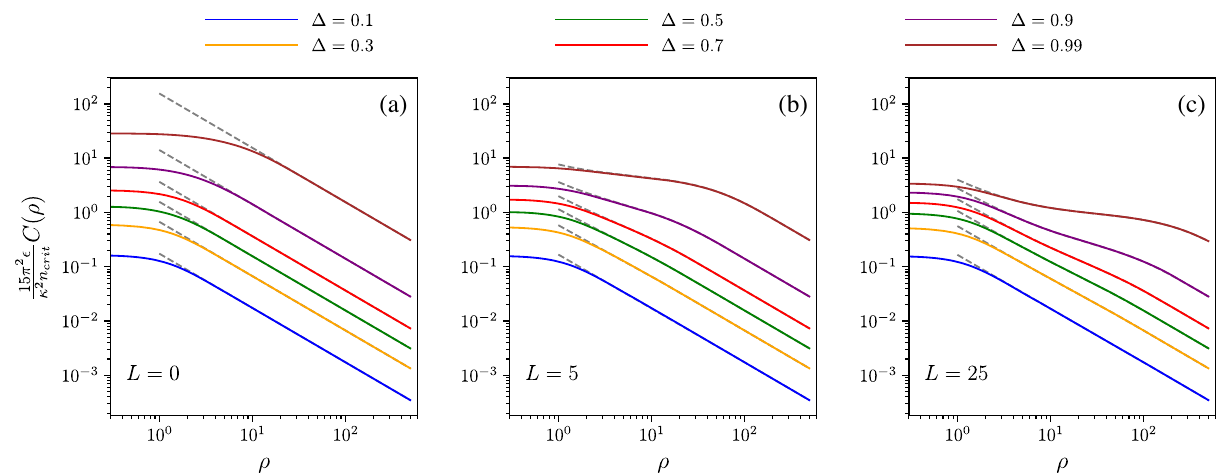
FIG. 2. The spatial correlation function C ð ρ Þ as a function of the distance ρ for various values of Δ . (a) L ¼ 0 , (b) L ¼ 5 , and (c) L ¼ 25 . The solid lines are calculated by numerically evaluating Eq. (67), while the dashed lines are the analytic approximation [Eq. (68)]. The legend applies to all panels.